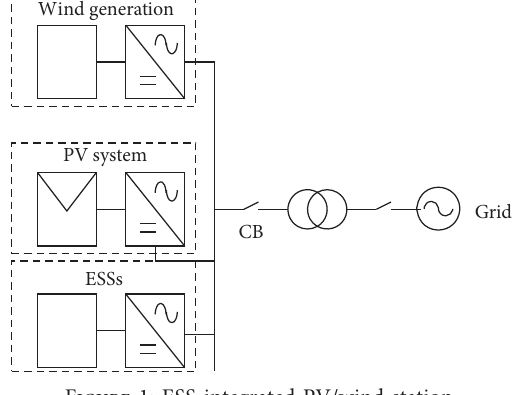
Figure 1: ESS-integrated PV/wind station.